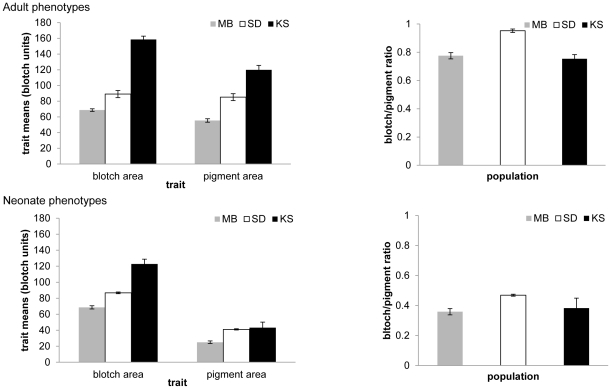
Trait means of two color traits in Thamnophis sirtalis from three Midwestern populations.MB = Manitoba, SD = South Dakota, KS = Kansas. Left-hand charts show means for blotch area and pigment area. Right-hand charts give means for blotch area/pigment area ratio. The upper panels are for neonates and the bottom panels are for adults. Error bars represent plus or minus one standard error of the mean. All means were significantly different from one another at or below the P = 0.0001 level except for the KS-MB pigment comparison for pigment (P<0.0003) and the KS-MB ratio comparison for adults (P = 0.0997) and neonates (P = 0.83) as well as two SD-KS neonate comparisons: pigment area (P = 0.88) and the blotch area/pigment area ratio (P = 0.75).